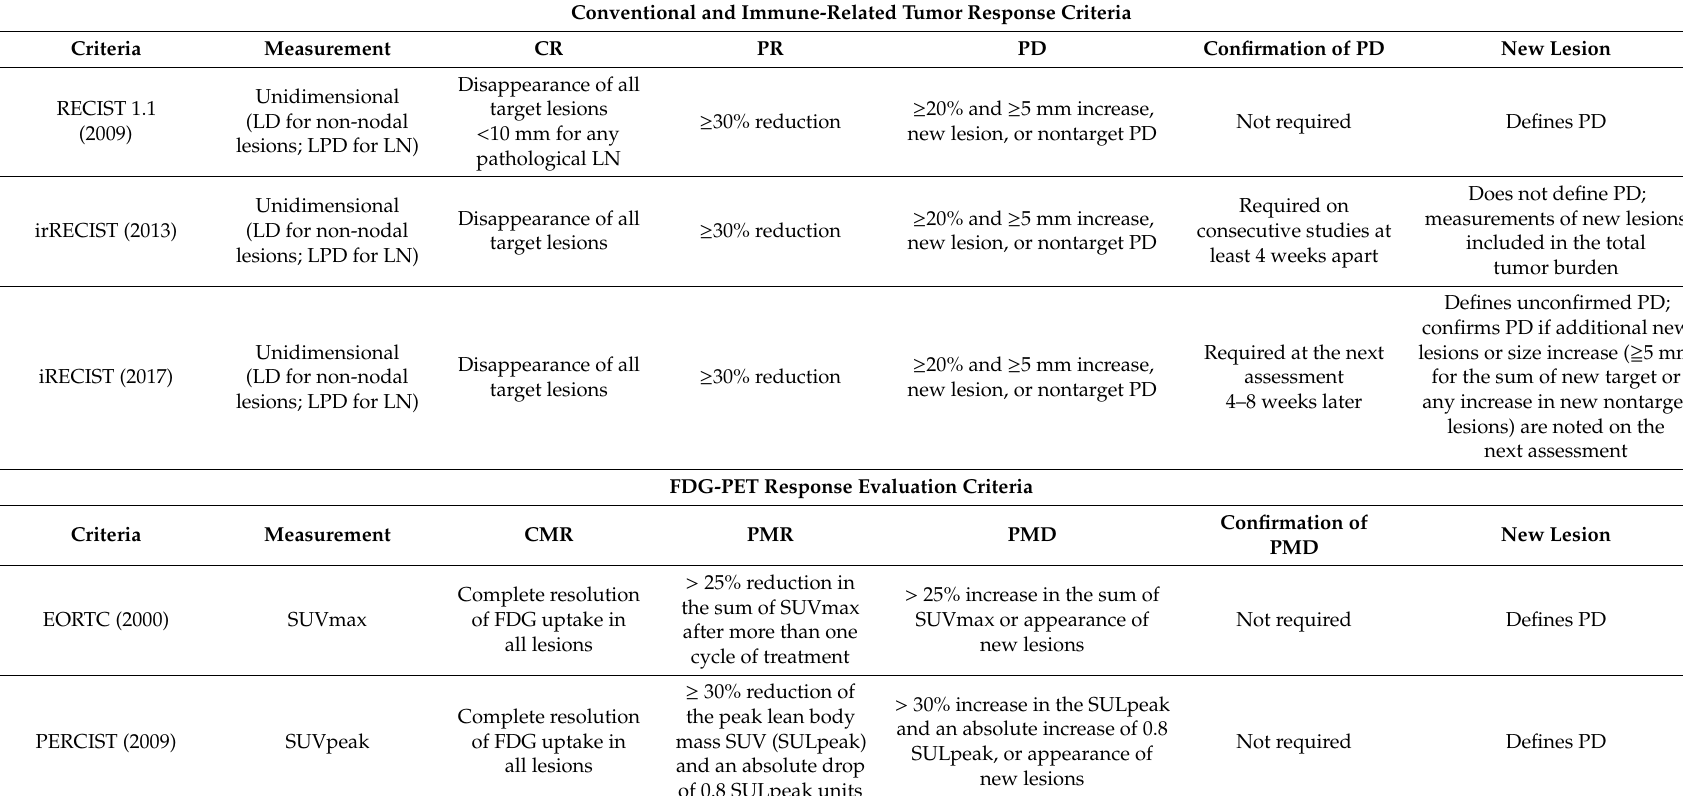
Table 1. Conventional / Immune-Related Tumor Response Evaluation Criteria and 2-[ 18 F] fluoro-2-deoxy- d -glucose positron emission tomography (FDG-PET) Response Evaluation